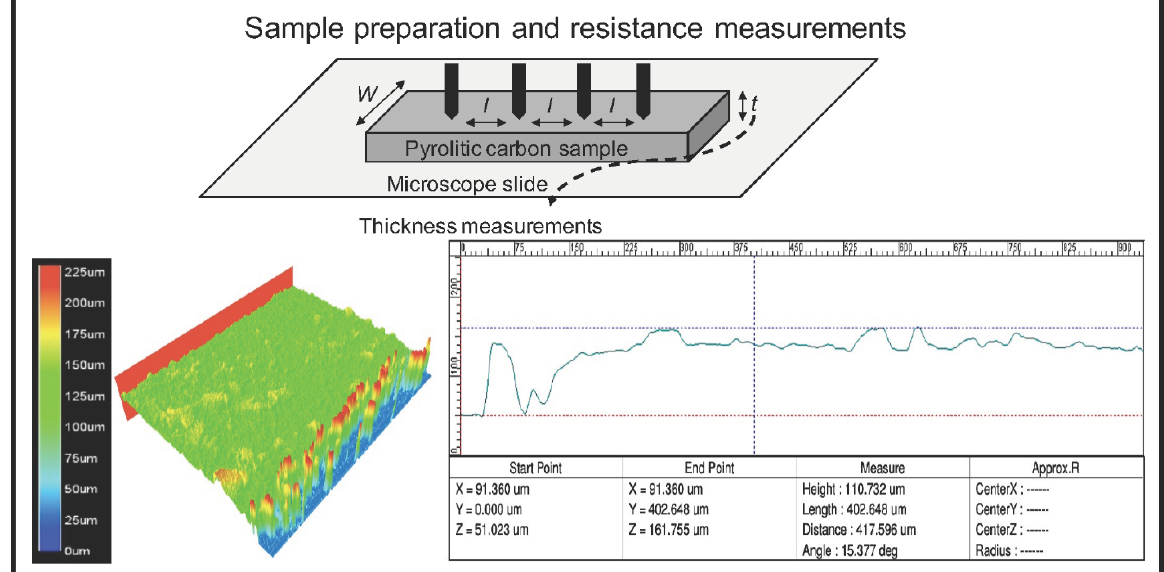
Figure 2. Four-point methodology (upper panel: schematic representation of the four-point probe device; lower left panel: visualization of the sample thickness distribution; and lower right panel: average longitudinal thickness of the sample).